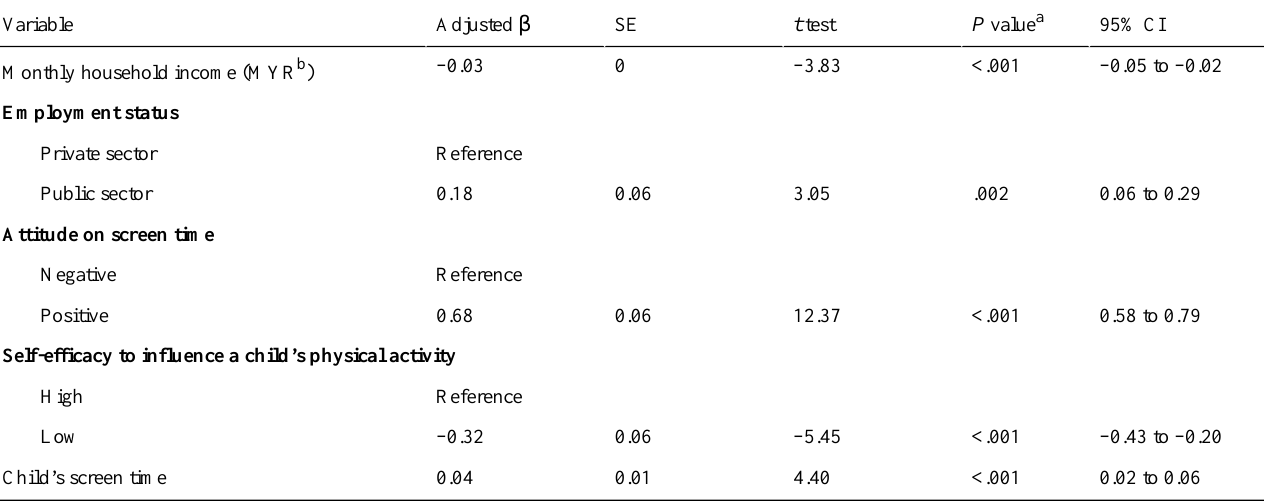
Table 4. Predictors of parental barriers to reduce excessive child screen time